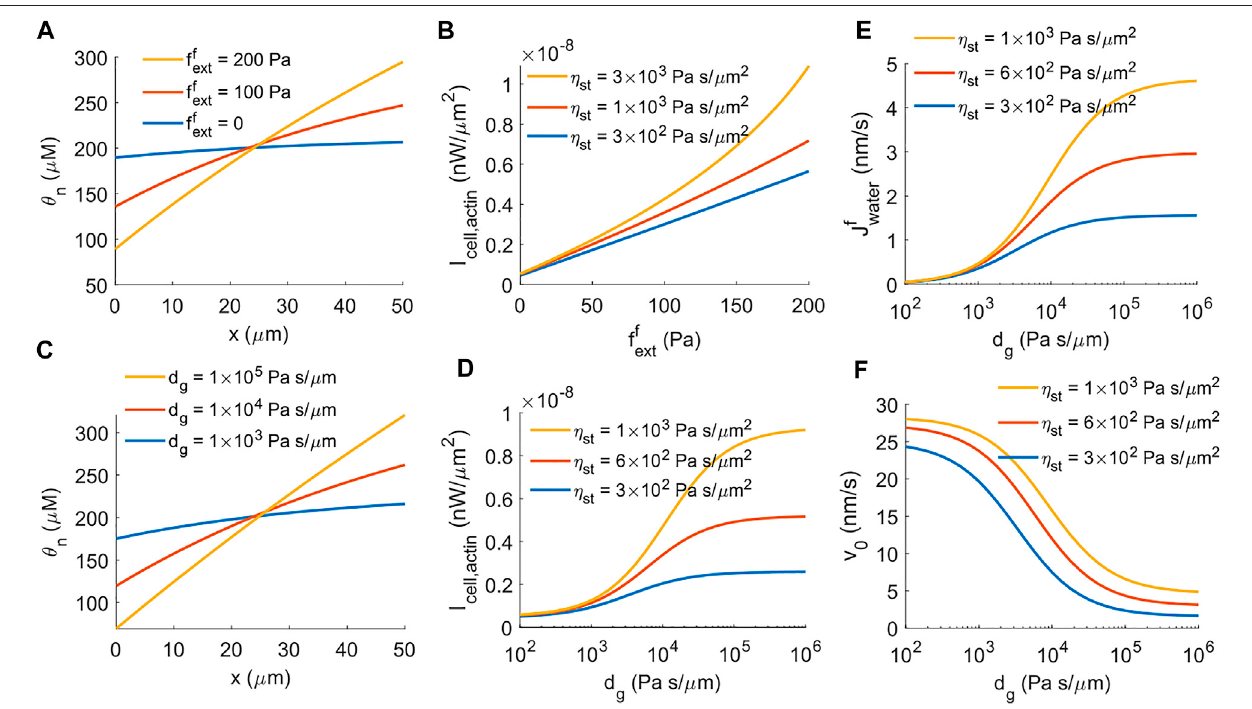
FIGURE 3 | The impact of external force on the energy generation of actin-driven cell migration. (A) Spatial distribution of F-actin concentration for different magnitudes of external force per unit cross-sectional area, J f ext . (B) Power generation from the actin network as a function of the external force per unit cross-sectional area, J f ext , for different strengths of focal adhesion, η st . (C) Spatial distribution of F-actin concentration for different coef fi cients of external hydraulic resistance, d g . (D) Power generation from the actin network as a function of the coef fi cient of external hydraulic resistance, d g , for different strengths of focal adhesion, η st . (E) Under actin-drivencellmigration,water fl uxacrossthecellasafunctionofthecoef fi cientofexternalhydraulicresistance, d g ,fordifferentstrengthsoffocaladhesion, η st . (F) The velocity of actin-driven cell migration as a function of the coef fi cient of external hydraulic resistance, d g , for different strengths of focal adhesion, η st .